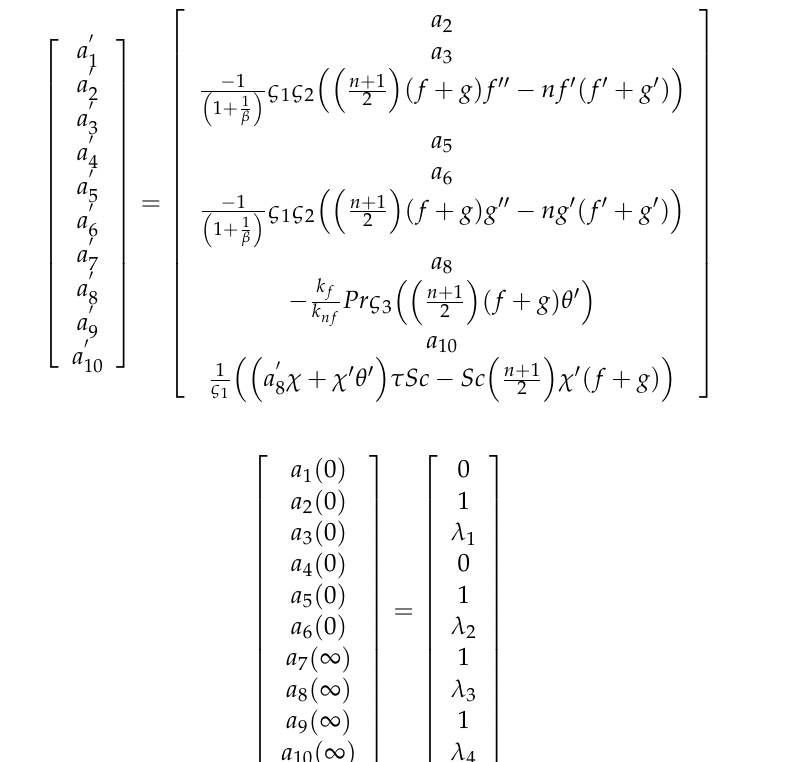
Table 1. Nanoparticle and base liquid thermophysical characteristics (see Khan et al. [24]). Property